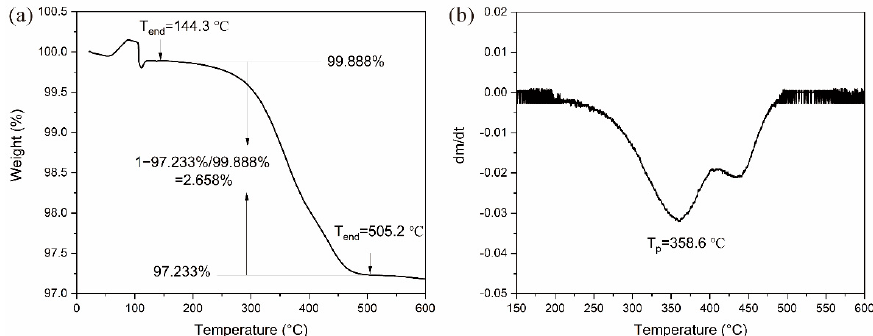
Figure 9. ( a ) TGA curve of WO 3 · 0.33(H 2 O); ( b ) the first derivative of TGA curve. The first derivative curve is smoothed by Savitzky-Golay method with window of 20 points.